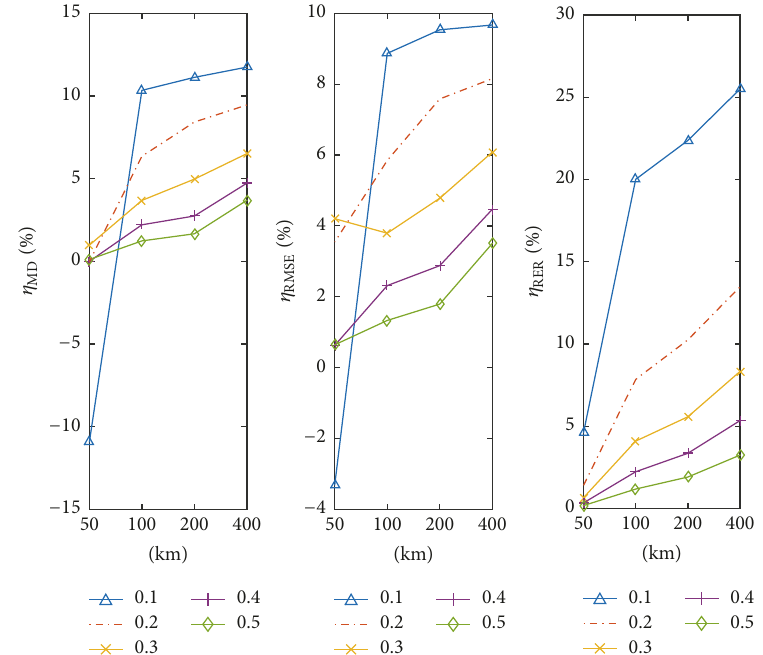
Figure 7: Variations of 𝜂 MD ( % ) , 𝜂 RMSE ( % ) , and 𝜂 RER ( % ) as functions of exclusion distances (50, 100, 200, and 400 km) for different values of 𝛼 when CTP